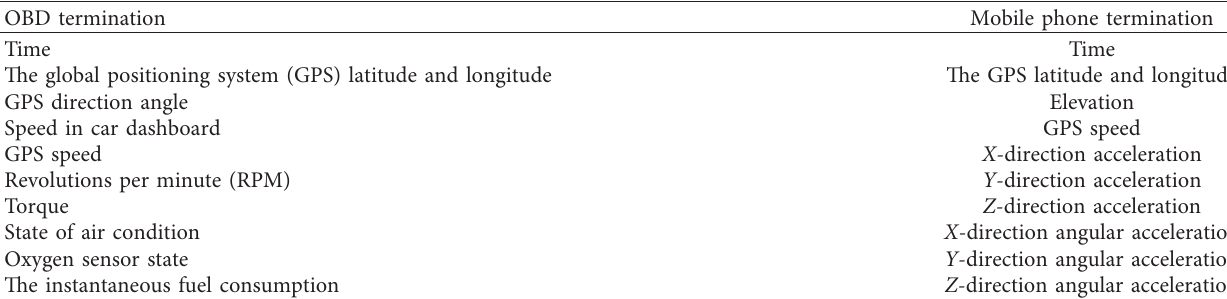
Table 1: Data types collected from the OBD terminal and mobile phone terminal.